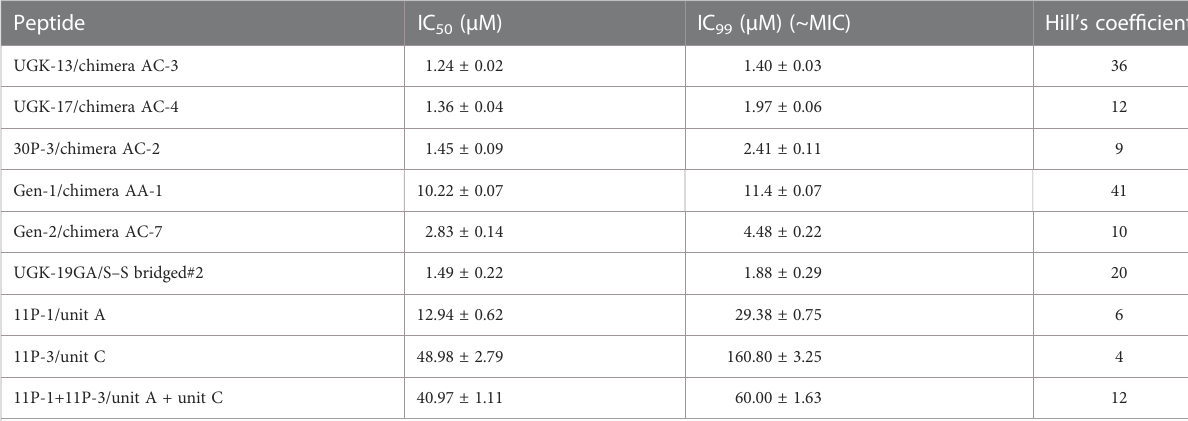
TABLE 2 Bactericidal activity of the selected a / b peptides measured using the bioluminescence assay. Peptide